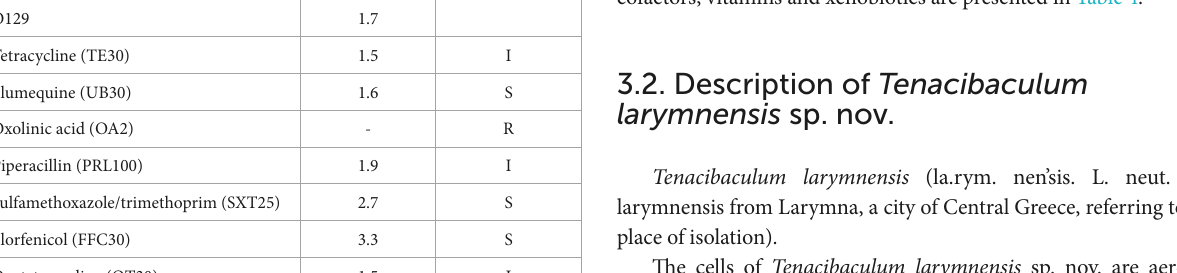
TABLE 1 Antibiotic susceptibility of Tenacibaculum sp. LAR 25.